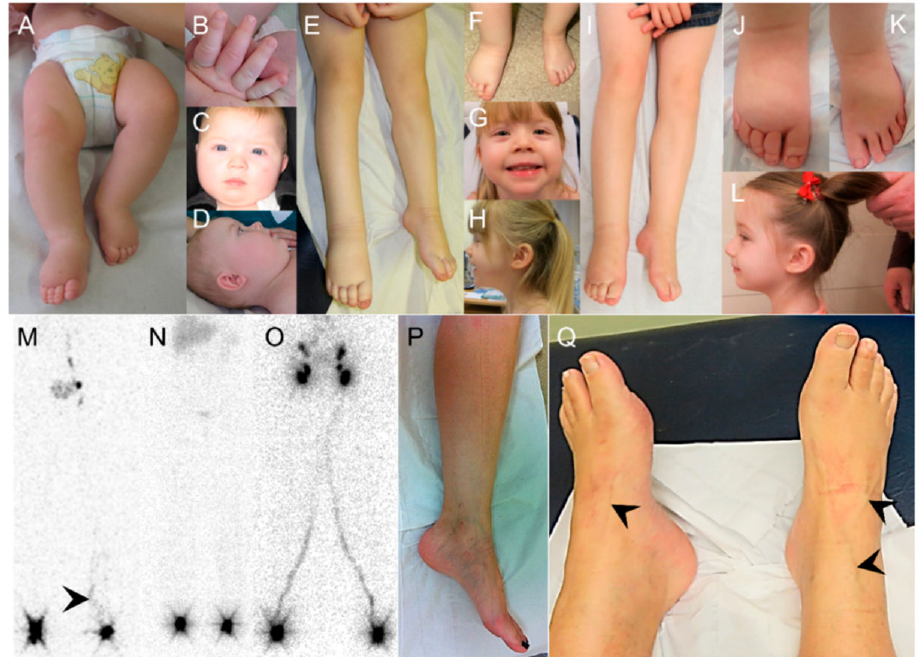
Figure 1. Clinical phenotype of the proband, mother and maternal grandfather and anterior view of lower limb lymphoscintigraphy. ( A – D ) Proband at her first visit to the genetics clinic at six months. ( A ) The proband presented as a baby with bilateral lower limb lymphedema. Swelling of the dorsum of the feet was obvious. Deep inter-phalangeal creases and small dysplastic nails were seen. ( B ) There was mild swelling in the hands. ( C ) She also had subtle dysmorphism with a round face, high forehead, short neck, hypertelorism, and depressed nasal bridge. ( D ) There was mild bilateral ear dysplasia and right pre-auricular sinus. ( E – H ) Proband at two years and 10 months. ( E , F ) The proband had persistent bilateral lower limb lymphedema of the feet, which extended up the leg to the knees and was more pronounced on the right. ( G ) Subtle dysmorphic features with a round face, hypertelorism, downslanting palpebral fissures, and depressed nasal bridge. ( H ) Slightly low, posterior rotated ears with mild ear dysplasia. ( I – L ) Proband at four years and eight months. ( I ) Proband presented with persistent bilateral lower limb lymphedema to the knees. ( J , K ) The swelling was particularly noticeable in the dorsum of the foot, which was more marked in the right foot ( J ) than the left ( K ). ( L ) Slightly low, posterior rotated ears. ( M ) Lymph scan (anterior view) of proband showing no evidence of uptake of the tracer in the right lower limb lymphatic tracts or inguinal lymph nodes after 3 h (functional aplasia). Uptake in the left lower limb lymphatic vessels remains abnormal and reduced (functional hypoplasia). The left lower leg lymphatic vessels are tortuous in the calf region (arrow head). ( N ) Lymph scan of a patient with typical Milroy disease with no evidence of main-tract filling nor rerouting (functional aplasia). ( O ) Lymph scan of healthy control. ( P ) The mother of the proband (III.1) presented with mild varicose eczema and multiple superficial veins around the ankles. There was also subtle lymphedema on the medial aspects of the ankles. ( Q ) The maternal grandfather (II.2) had bilateral mild varicose veins. There is noticeable mild lymphedema of the left ankle and varicose veins of both lower limbs (arrow